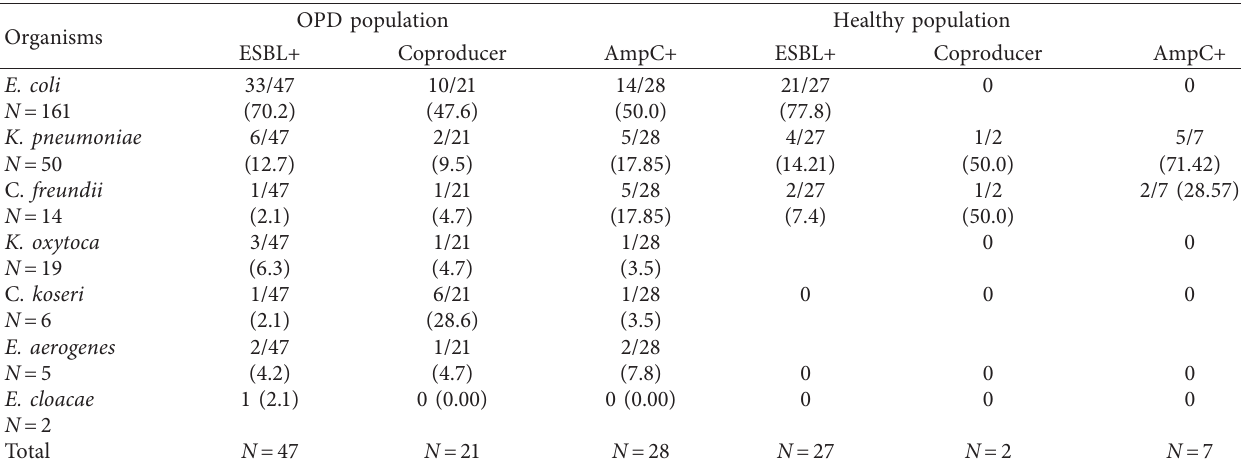
Table 3: ESBL, AmpC- β -lactamase, and coproducer positive isolates in different species from hospital and community setting.